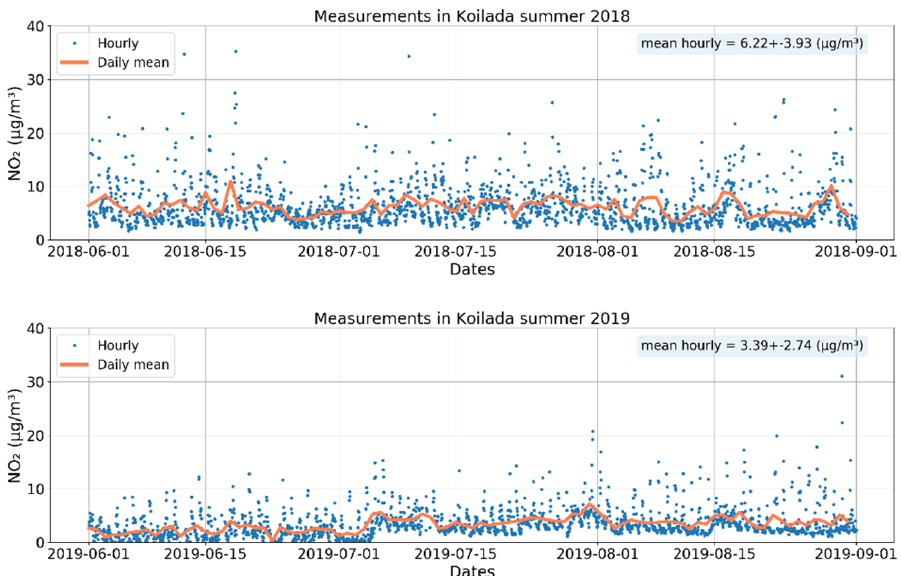
Figure 4. Time series of NO 2 hourly measurements (blue dots) at the station of Koilada and the daily mean NO 2 (orange line) for the summer of 2018 ( top ) and 2019 ( bottom ).